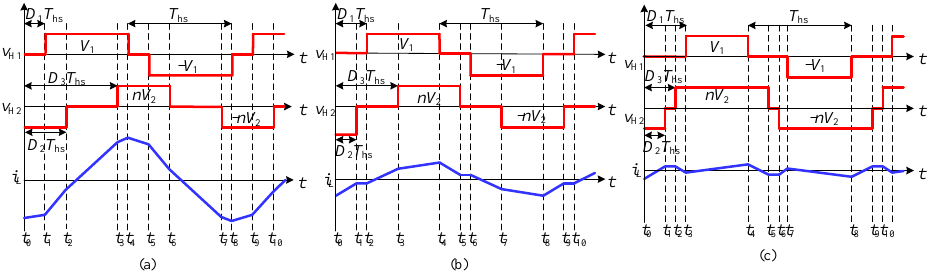
Figure 3. Switching times and steady–state waveform of different modes under TPS Control: ( a ) mode 1, ( b ) mode 2, ( c ) mode